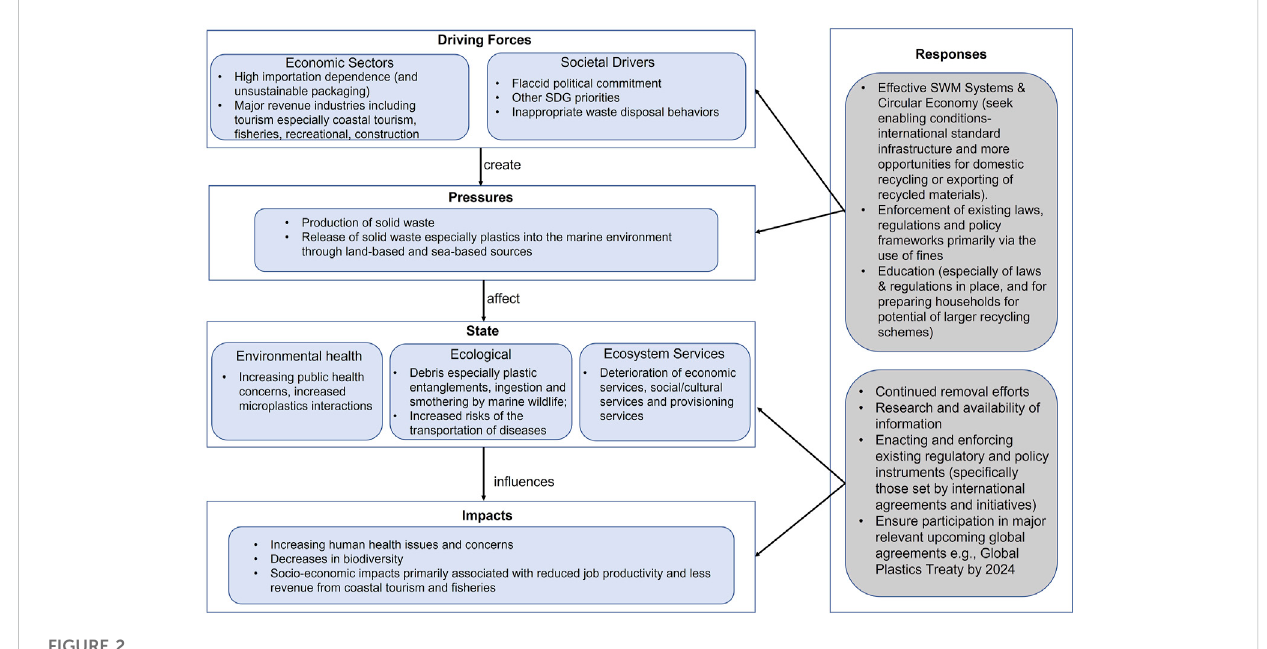
FIGURE 2 DPSIR analysis for marine litter in the Windward